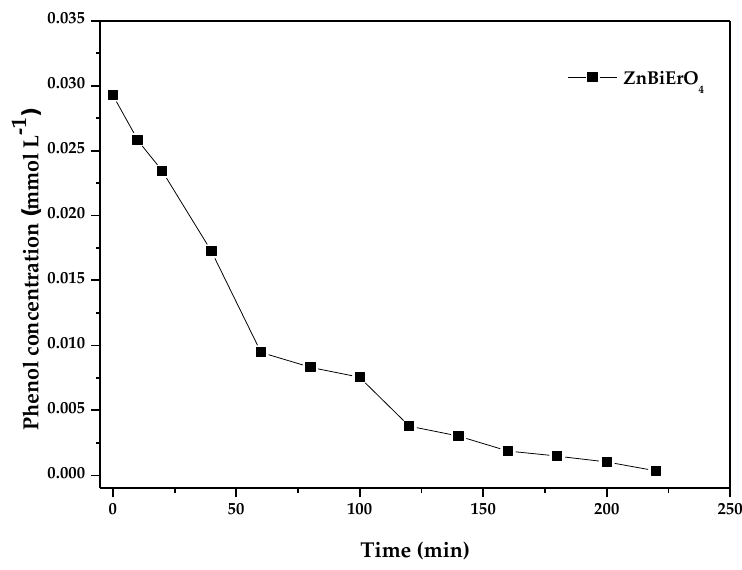
Figure 20. The photocatalytic degradation of phenol with ZnBiErO 4 as a photocatalyst under visible light irradiation.